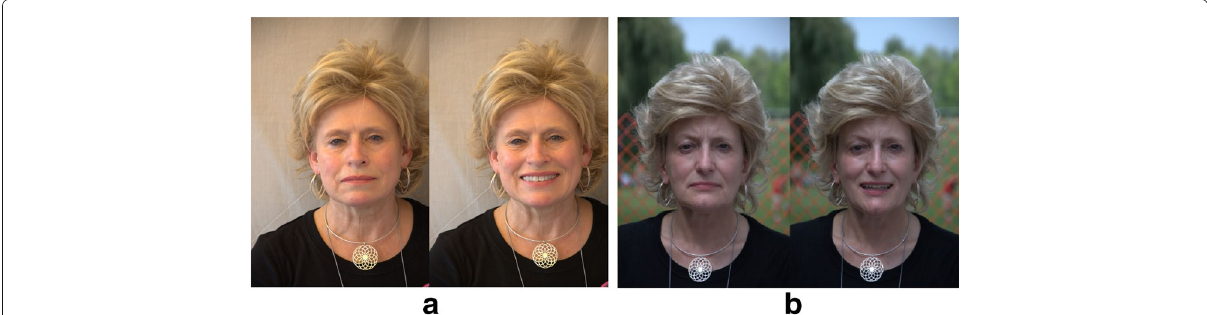
Fig. 4 Example frontal faces. Images in a are of the first twin under different expression and controlled illumination while images in b are of the second twin under different expression and uncontrolled